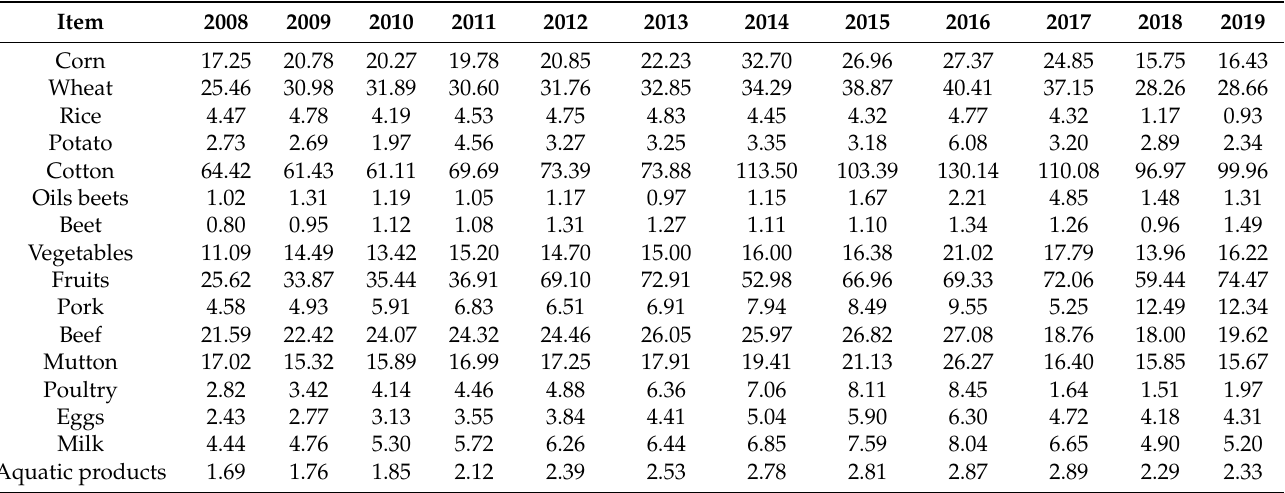
Table 5. Virtual water content of agricultural and livestock products in Tarim River basin. (Unit: hundred million m 3 ).